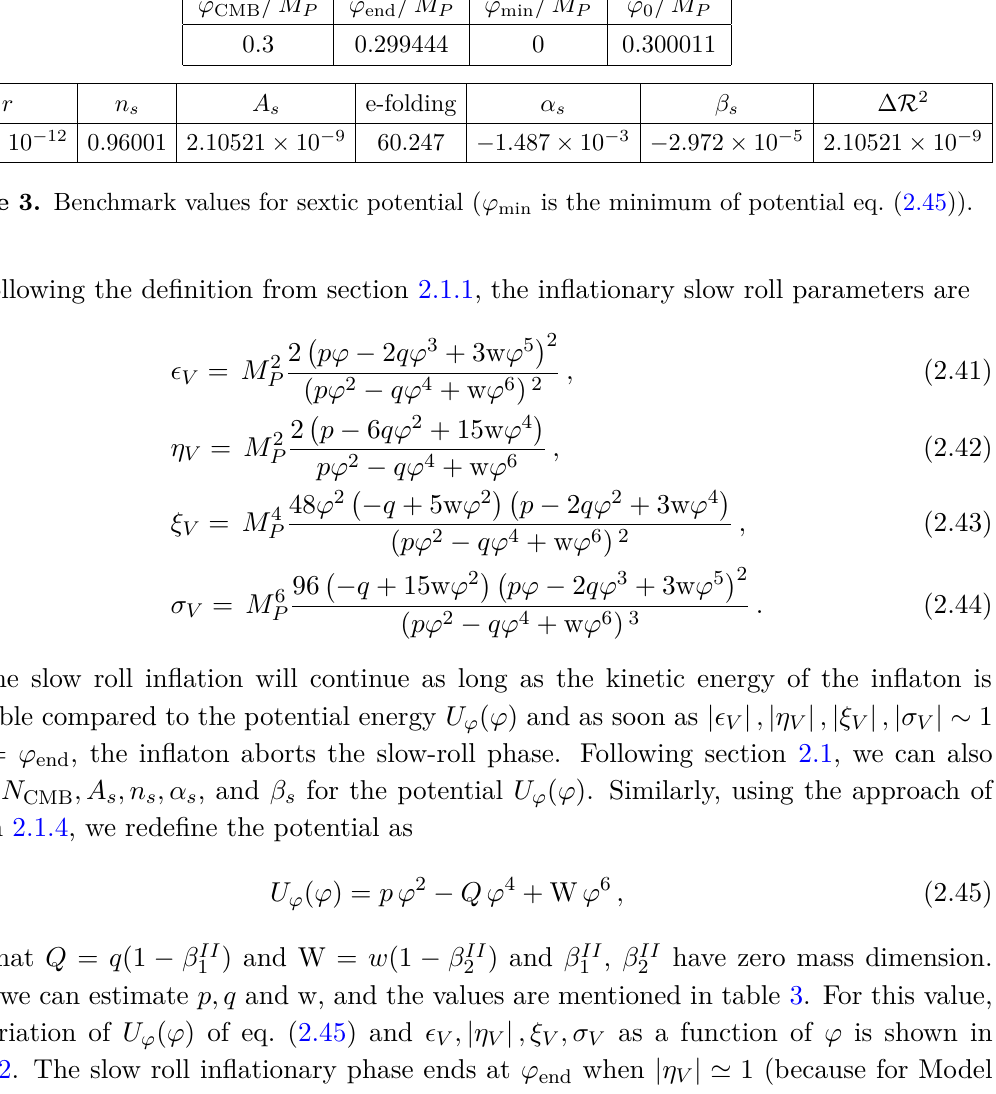
figure 2. The slow roll inflationary phase ends at ϕ II (cid:15) < | η | V V